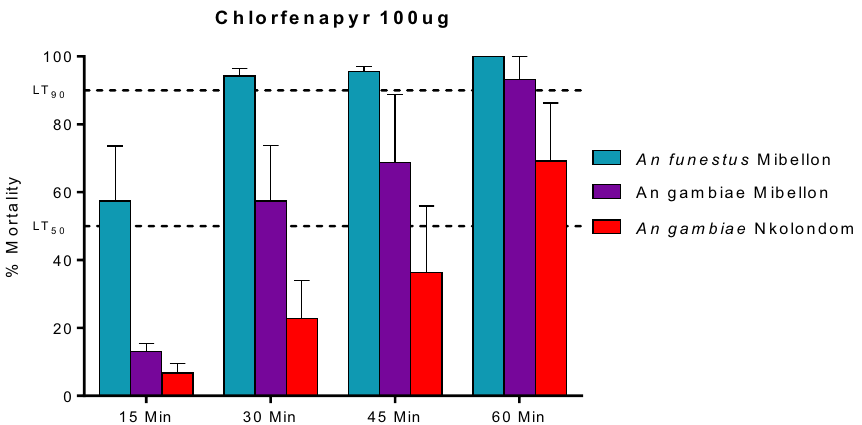
Figure 4. Susceptibility profile of An. funestus s.s (Mibellon) and An. gambiae (Mibellon and Nkolondom) populations to chlorfenapyr 100 µg/ml at different time points. Error bars represent standard error of the mean. Min